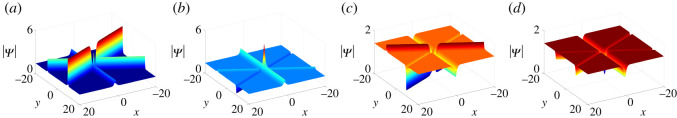
Three-soliton solutions of equation (1.3) at t = 0 with parameter values κ = 1, ξi0 = ηi0 = 0, i = 1, 2, 3, p2 = q1, q2 = p1, q1=p1∗, q3 = p3, p1 = 1 + i, c3 = −1/2 + i and (a) p3 = 1, c1 = −1 + i/2, (b) p3 = 1, c1 = 3 − 10i, (c) p3 = −1, c1 = 3 − 10i, (d) p3 = −1, c1 = 10 − i.